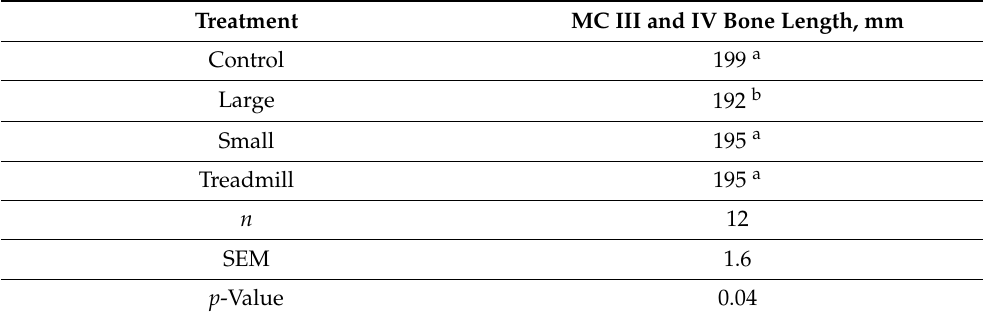
Table 3. Bone length of the right and left metacarpal III and IV (MC III and IV) by